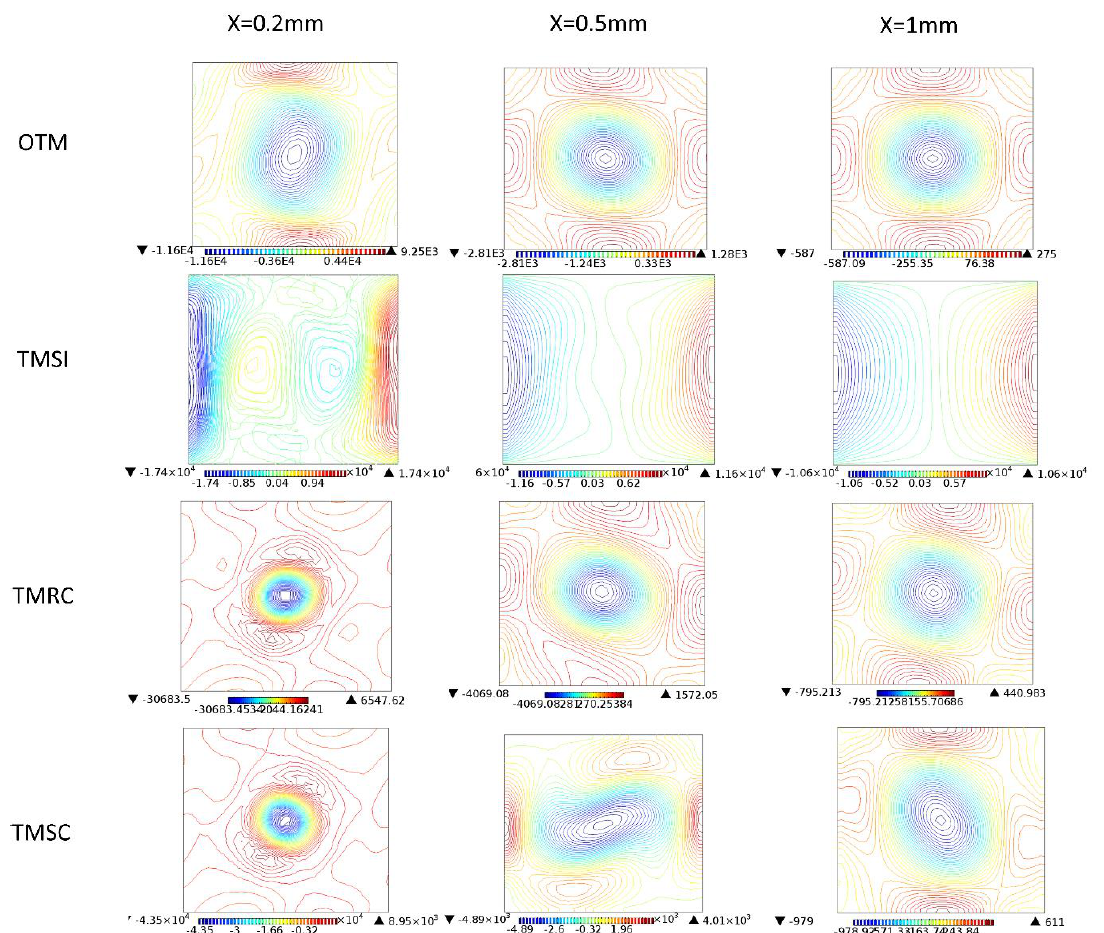
Figure 11. The normal ( x ) vorticity streamline for the four micromixers at x = 0.2 mm, 0.5 mm, 1 mm.